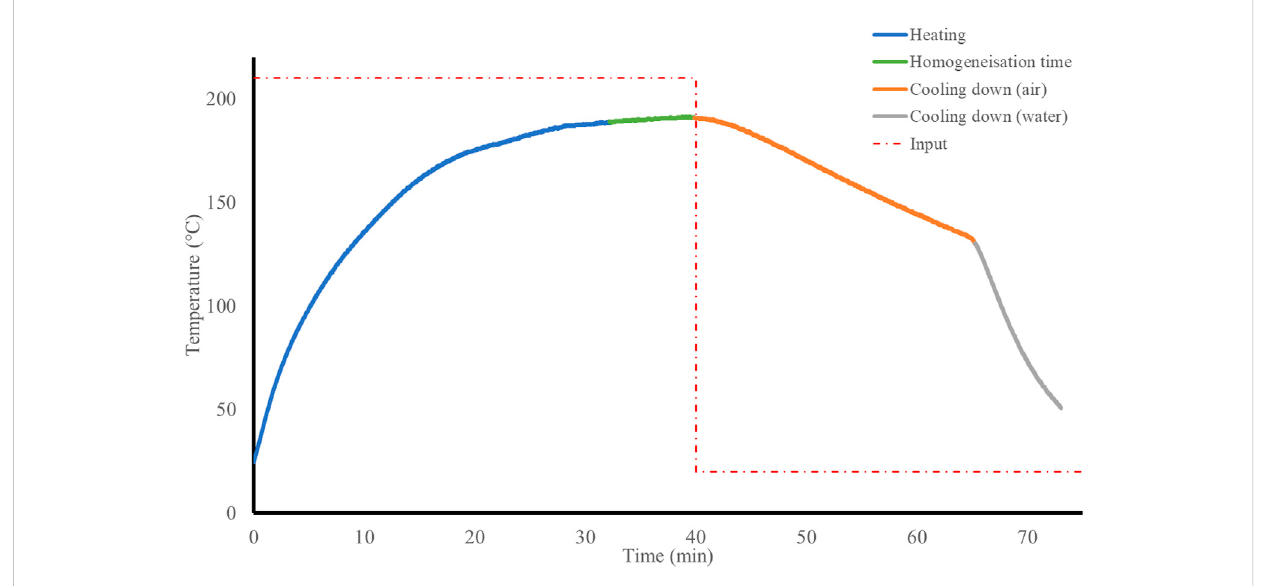
FIGURE 4 Heating and cooling cycles during the consolidation process of the Flax/PP prepregs.